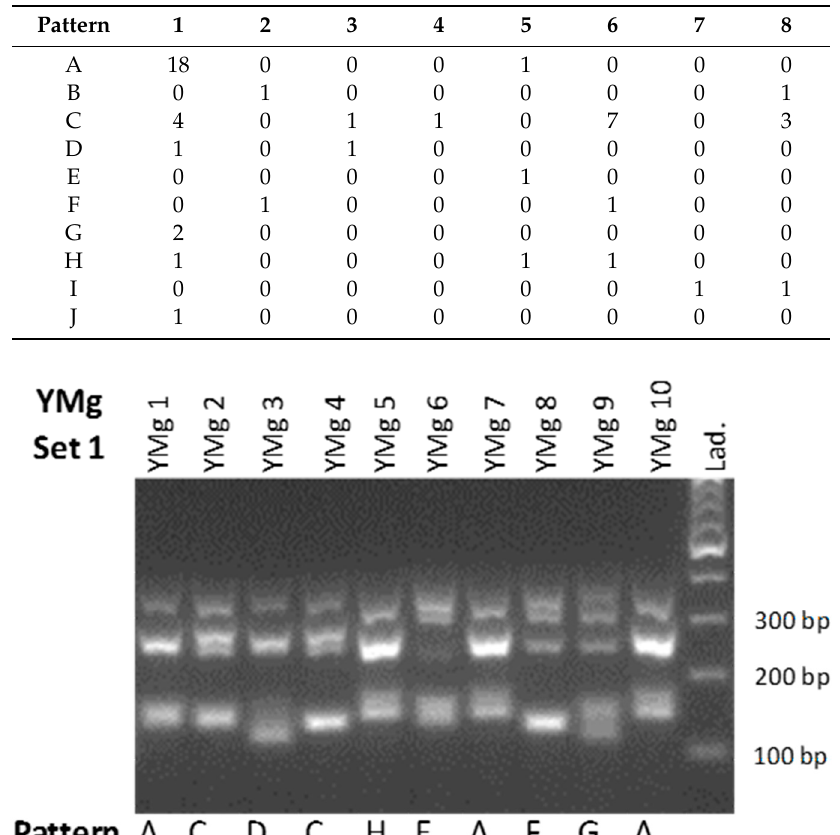
Table 4. Number of patterns obtained by gel electrophoresis for the winery’s own yeast after SSR PCR using multiplex set 1 (1 to 8) and multiplex set 2 (A to J).